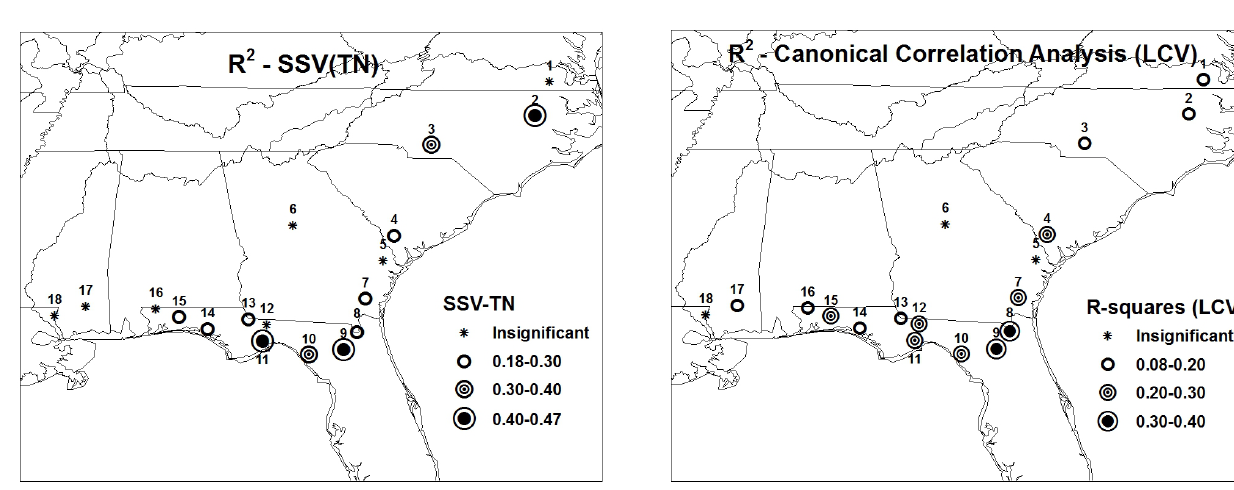
Figure 5: Modified R 2 (based on equation (3)) of canonical correlation analysis (CCA) model R 2 (based on Eq. 3) of canonical correlation anal- predicted TN loadings obtained using PC’s of forecasted precipitation under LCV. Fig. 5. Modified ysis (CCA) model predicted TN loadings obtained using PCs of forecasted precipitation under